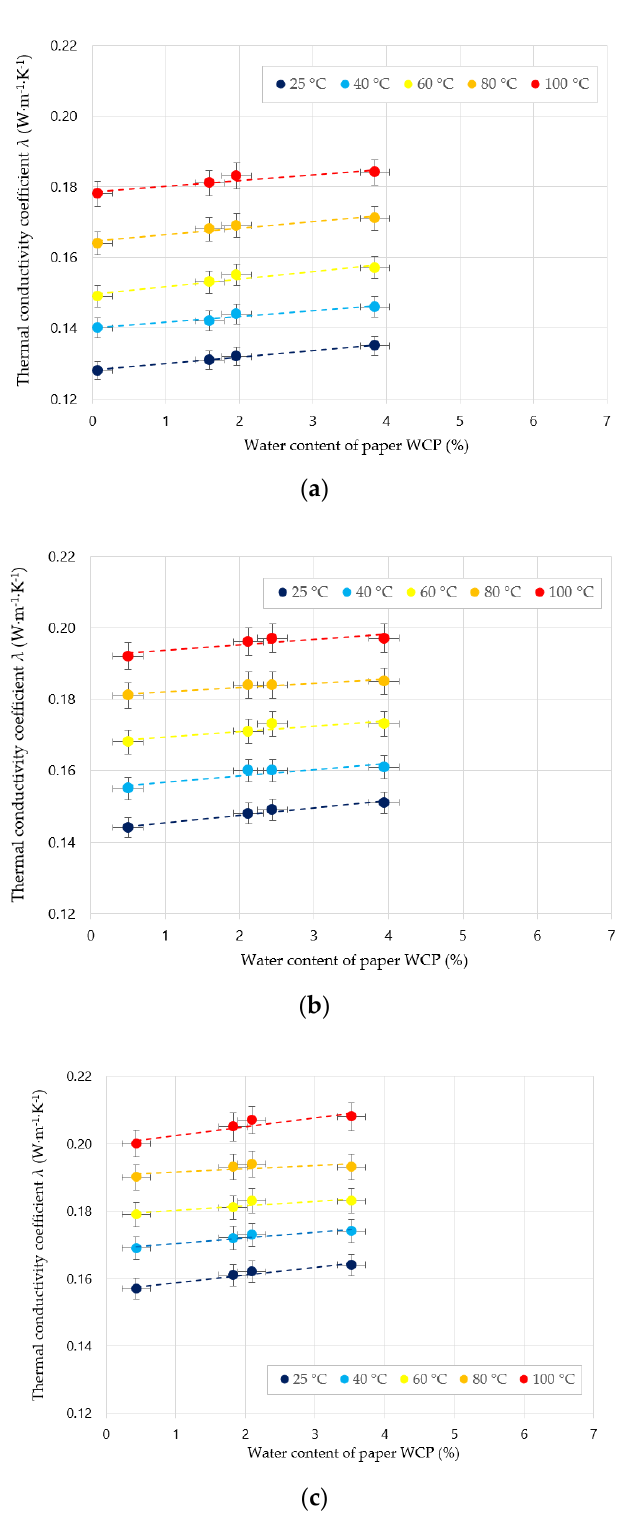
Figure 3. Thermal conductivity coefficient λ of aramid paper impregnated by various dielectric liquids depending on the water content of paper WCP and temperature T : ( a ) aramid paper impregnated by mineral oil; ( b ) aramid paper impregnated by synthetic ester; ( c ) aramid paper impregnated by natural ester.